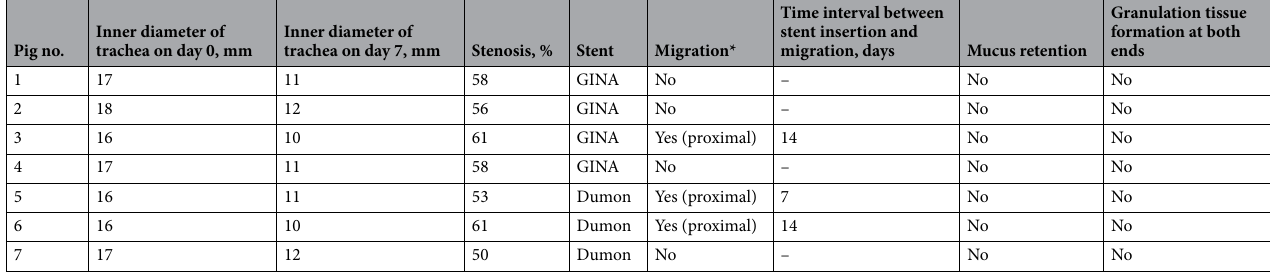
Table 1. Short-term (3 weeks) performance of the GINA stent, compared to the Dumon stent, in a porcine model of tracheal stenosis. * P = 0.486 for GINA versus Dumon.